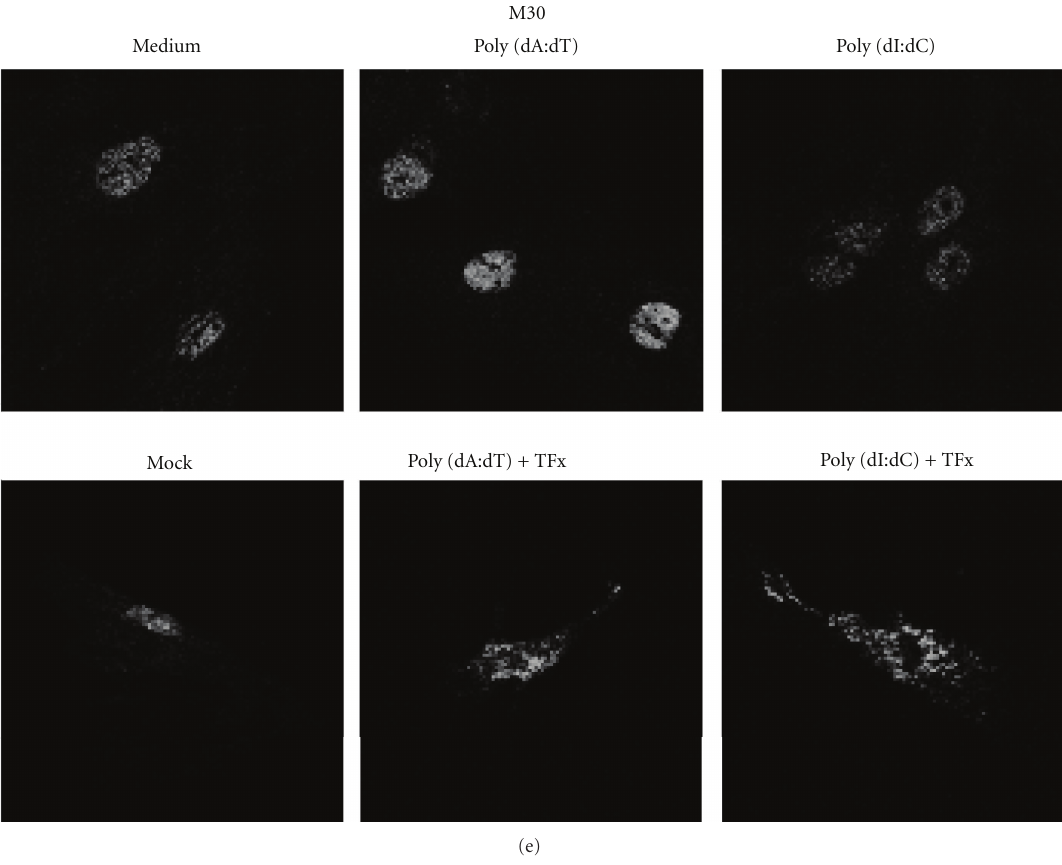
Figure 5: Double-stranded DNA (dsDNA) impaired cell-specific function. Cell-specific functions were impaired by intracellular dsDNA (at 1–10 μ g/mL) and extracellular poly (dI:dC) (at 10 μ g/mL) (a), (b). Intracellular dsDNA (at 10 μ g/mL) attenuated cell proliferation of PSCs (c)–(e). TFx: + transfection reagent lipofectamine. ∗ P < 0 . 05, ∗∗ P < 0 .